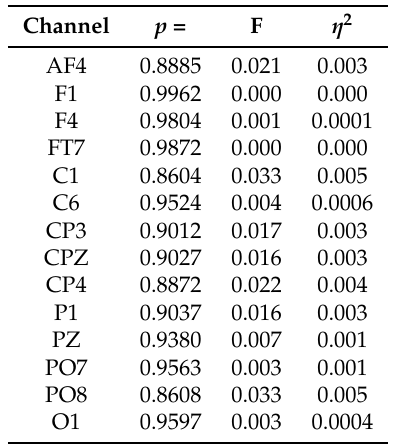
Figure A4. Eyes-Open GLM analysis using logistic regression with sigmoid function to determine the importance of each of the significantly different channels between HIGH and LOW stress-susceptible groups for predicting participants’ group membership (i.e., HIGH versus LOW). Channels with significantly different total TEs were AF4, F1, F4, FT7, CP3, CP4, CPZ, C1, C6, P1, PZ, PO7, PO8, and O1. Each bar in this subplot corresponds to one GLM coefficient, per channel, per group. ANOVA analysis of these weights indicated non-significant difference between contribution of these channels individually and in comparison to other channels’ contribution. Blue line in each subplot marks the average of these coefficients, per setting. Red lines mark the 95.0% confidence interval of these weights. Table A8. Eyes-Open (EO) setting. ANOVA analysis of GLM coefficients associated with the channels with significant difference in their total TEs between HIGH and LOW stress-susceptible groups. These channels were: AF4, F1, F4, FT7, CP3, CP4, CPZ, C1, C6, P1, PZ, PO7, PO8, and O1. This analysis identified a non-significant difference between contribution of these channels individually and in comparison with the other channels’